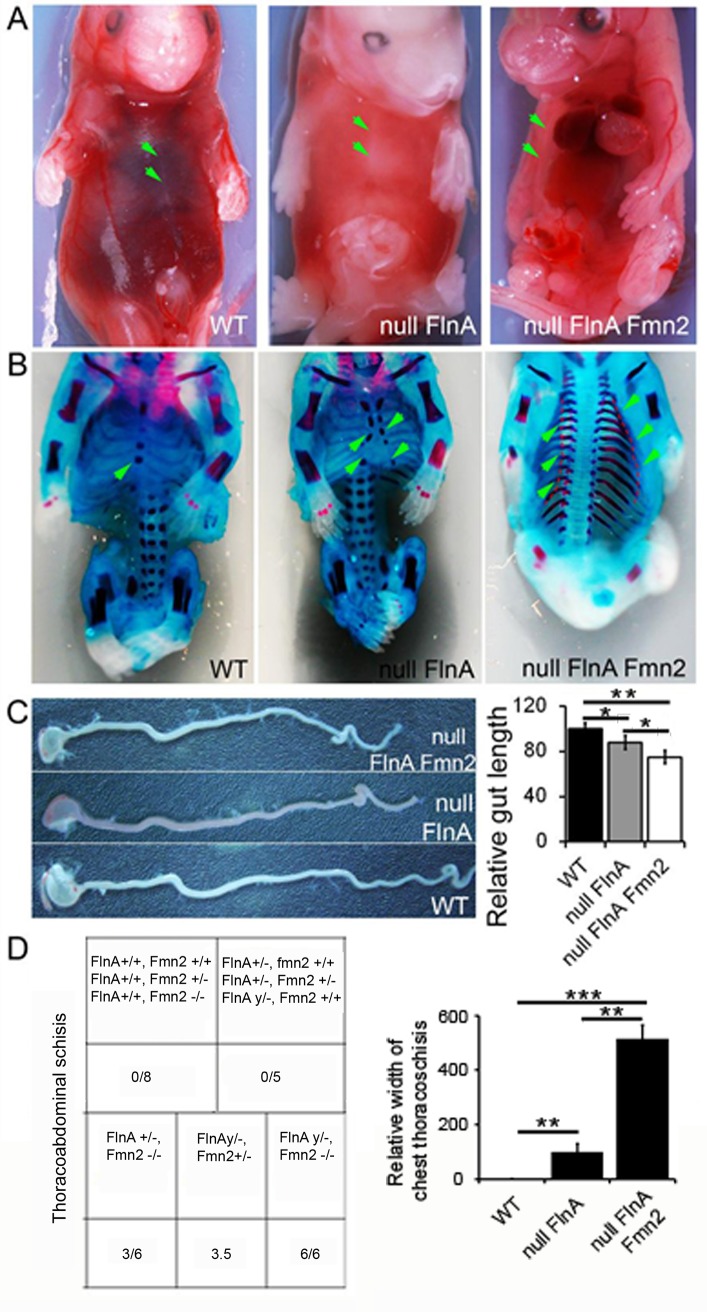
Loss of FlnA and Fmn2 causes a midline thoracoabdominal schisis, delayed bone formation and shortened gut.A. Gross anatomical photographs of FlnA+Fmn2 double knockout E15.5 embryos show a thoracoabdominal schisis that is characterized by midline extrusion of the heart and lungs in the ventral thorax, and the liver and intestines in the ventral abdomen. The overlying skin is also translucent and thinned. Noticeably, the ribcage/sternum (see green arrows) are localized to the lateral sides of the thorax in the null FlnA+Fmn2 mouse but was present in the ventral midline of WT or null FlnA mice (see arrows). B. Gross anatomical photographs of E15.5 mice following Alcian blue (cartilage) and Alizarin red (bone) staining shows a delay in development (ossification) of the ribcage in null FlnA+Fmn2 embryos, compared to null FlnA and WT age matched littermates. Midline closure of the sternum and ribs (green arrows) is completely absent in the double knockout mice, slightly delayed in the null FlnA mice and completed in the WT mice. The green arrows and dashed red lines in the null FlnA+Fmn2 mice indicate the contour of the sternum/ribs as they progress toward the midline. C. The intestines of null FlnA and null FlnA+Fmn2 embryos are shorter than that seen in WT embryos (WT vs null FlnA * = p <0.015, WT vs null FlnA+Fmn2 ** = p <0.004, null FlnA vs null FlnA+Fmn2 * = p <0.047). D. Findings of thoracoabdominal schisis formation in the null FlnA+Fmn2 mice during embryonic development are summarized in the table including the numbers of embryos examined. We also examined tens of null Fmn2 or null FlnA embryos from single gene-deleted mother. The results showed that loss of Fmn2 alone was insufficient to cause midline closure defects, and loss of FmnA caused a delay in midline closure as displayed in Fig 1B, but could lead to the formation of thoracoabdominal schisis. In contrast, approximately half of the heterozygous FlnA and Fmn2 embryos (3/6) or null FlnA and heterozygous Fmn2 embryos (3/5) actually developed thoracoabdominal schisis with extrusion of the organs through the midline, suggesting the additional effect of FlnA and Fmn2 functions on formation of thoracoabdominal schisis. Finally, all the null FlnA and Fmn2 embryos examined (6/6) developed thoracoabdominal schisis, contrast to only a midline closure delay for null FlnA embryos, indicating a significant difference in development of phenotypes between null FlnA alone and null FlnA and Fmn2 embryos. In addition, measurement of the schisis at the chest midline showed greater defects in midline closure in the double FlnA+Fmn2 null vs single FlnA null vs WT mice (graphically summarized, WT vs null FlnA: ** = p< 0.0017, null FlnA vs null FlnA+Fmn2: ** = p < 0.0025, WT vs null FlnA+Fmn2: *** = p < 0.0011).